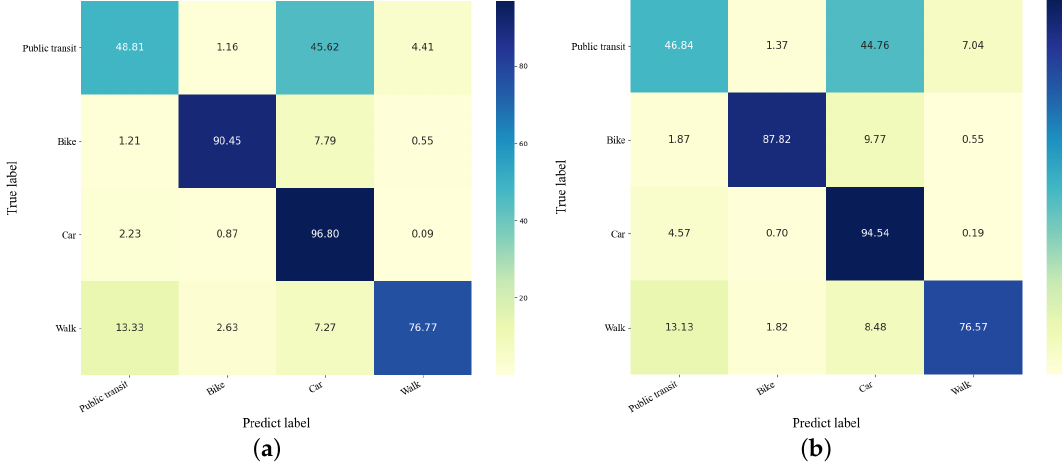
Figure 9. The confusion matrix of the MTL Trajet 2016 dataset. ( a ) Motion+GIS. ( b )